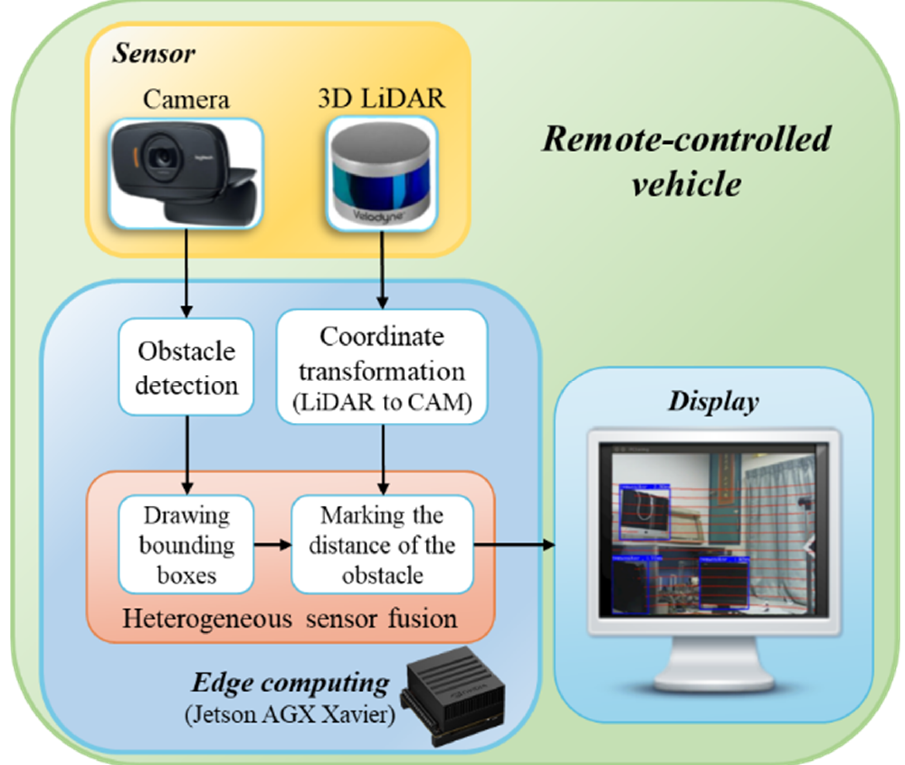
Figure 1. System architecture.